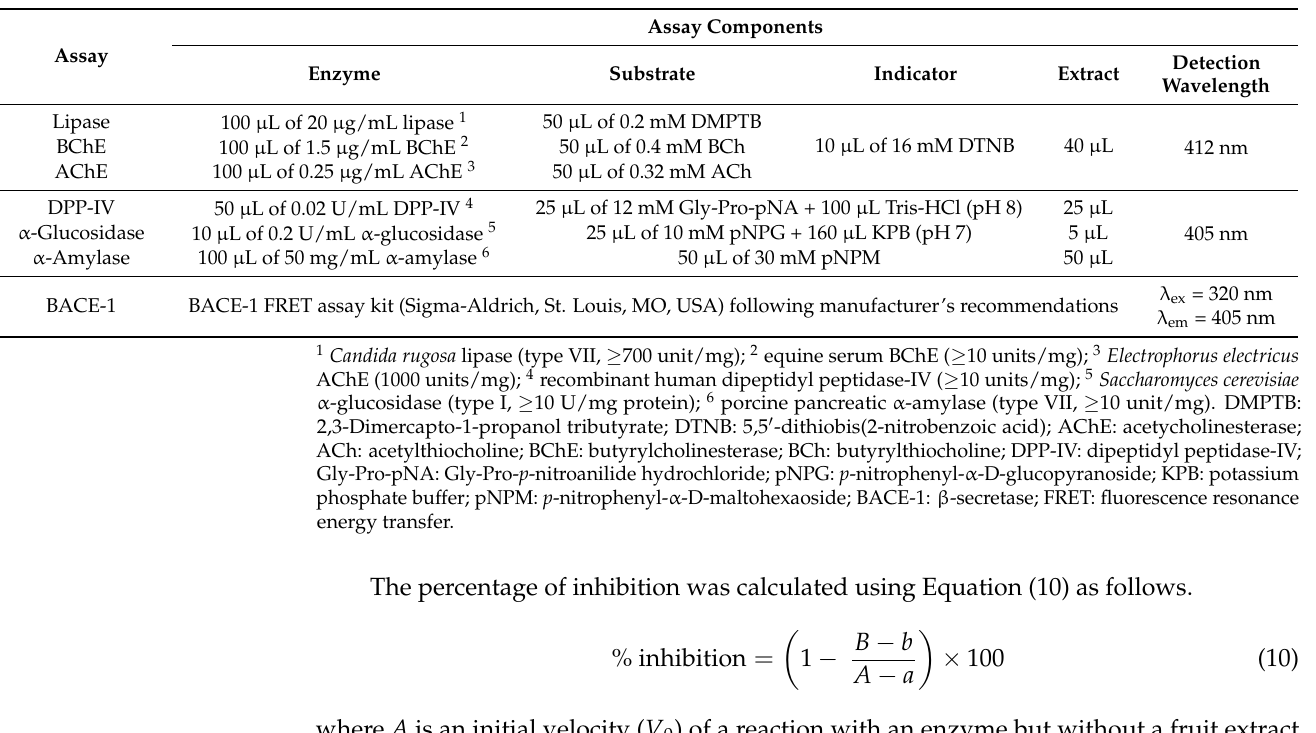
Table 1. The assay components including an enzyme, a substrate, an indicator, a fruit extract and a detection wavelength for enzyme inhibitory